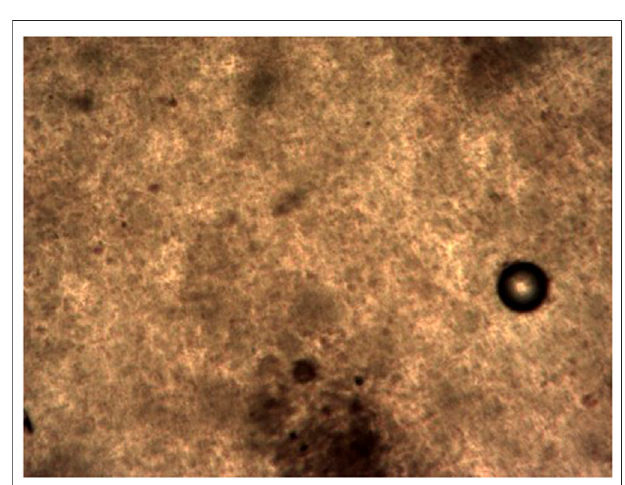
TABLE 7 | Effect of inorganic fl occulant on particle size distribution of PEM drilling fl uid. Flocculant/(1%)